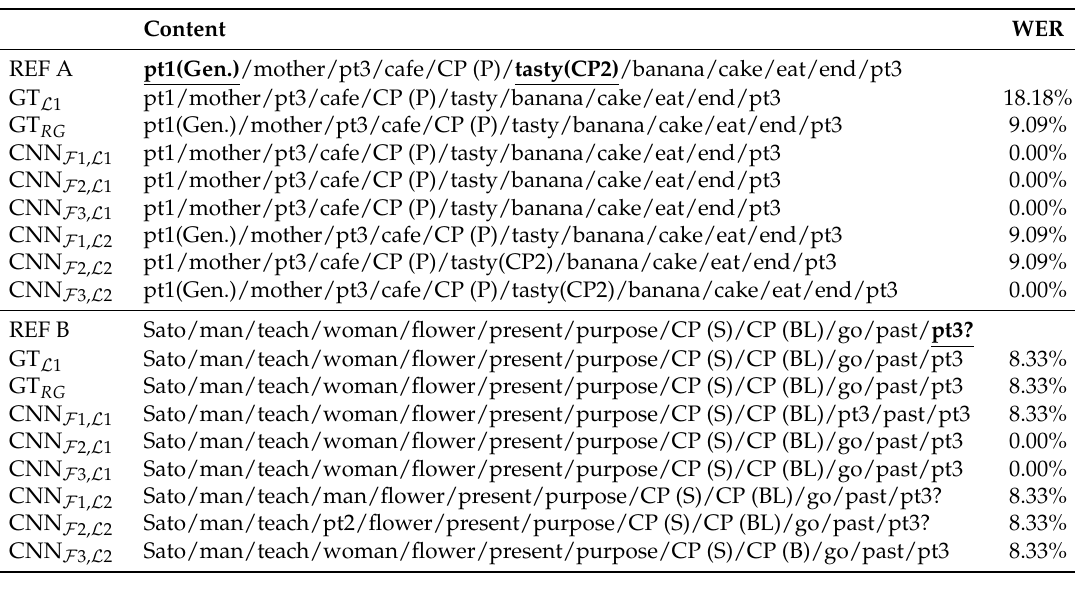
Table 5. Successful sample predictions as obtained from the different classifiers in comparison to their reference (REF) and the two ground truths GT L 1 and GT RG . NMEs in REF are highlighted by